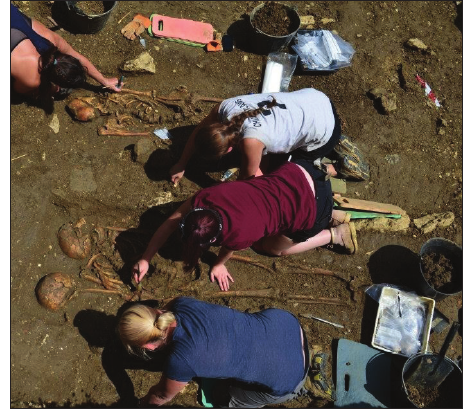
Figure 2: Mortuary archaeology field